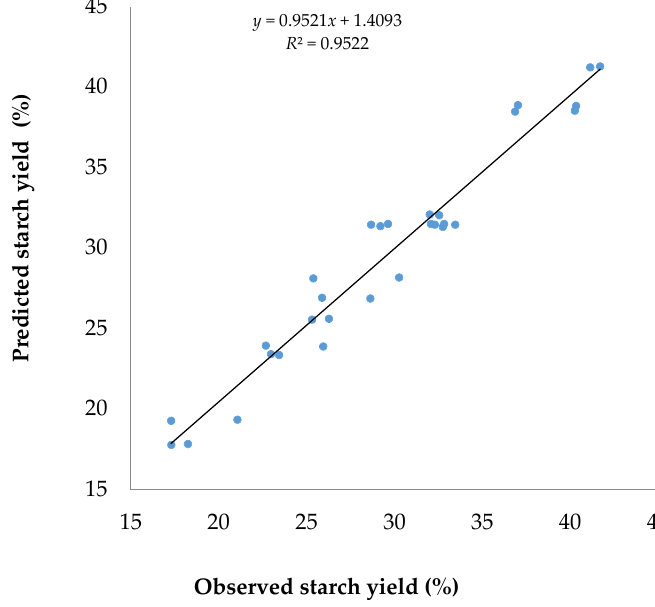
Figure 2. Predictions of regression models.